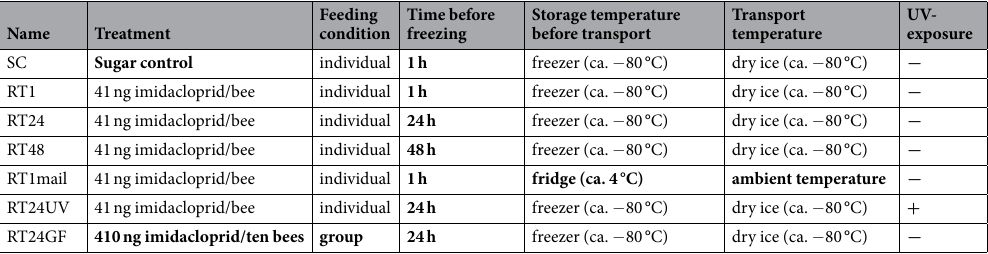
Table 1. Treatment conditions of experimental